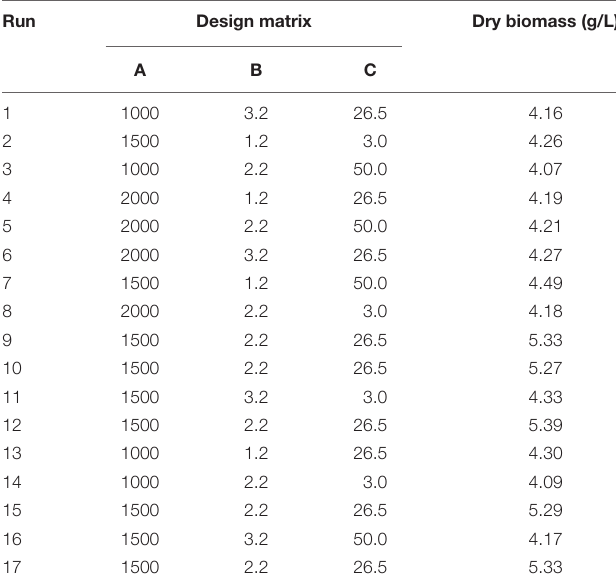
TABLE 2 | Box–Behnken experimental design matrix employed by DesignExpertTM V.10 with experimental results to predict optimum concentrations of medium components.